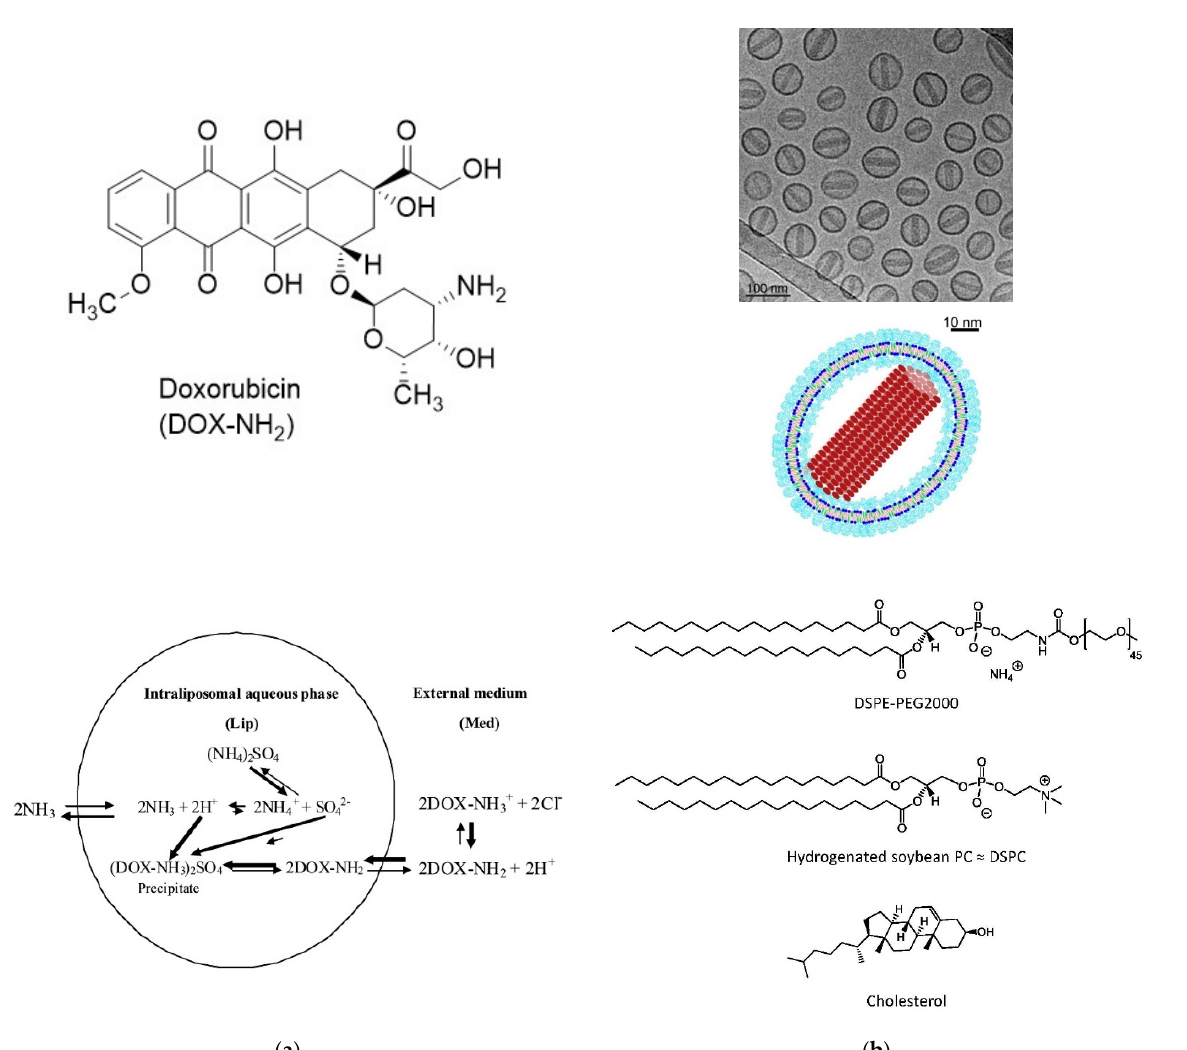
Figure 25. Doxil ® , as prepared by using the “remote loading method”. ( a ) Top : Chemical structure of doxorubicin (DOX-NH 2 ). The reported pK a -value of the protonated form of the amine (-NH 3+ ) of doxorubicin is 8.15 [323]. Bottom : Schematic representation of the remote loading of doxorubicin into pre-formed phospholipid vesicles. The loading is based on trans-membrane ammonium sulfate and pH-gradients, as published by Barenholz (2001) and (2012) [322,324]. The circle represents a phospholipid bilayer of a LUV, for example prepared by polycarbonate membrane extrusion; see Section 4.1. [323]. The arrows in bold indicate the situation during the loading process; see [324] and text for details. ( b ) Top : Cryo-TEM image of commercial Doxil ® , consisting of PEGylated phospholipid vesicles and internal doxorubicin precipitates, obtained via the remote loading mechanism shown in ( a ); see [324]. Middle : Illustration of the structure of a Doxil ® product vesicle (not drawn to scale), consisting of internal doxorubicin precipitates and a single bilayer composed of HSPC (hydrogenated soybean phosphatidylcholine), DSPE-PEG2000, and cholesterol [329] ( bottom ); see Section 6.2.1. Reproduced with permission from [324], Elsevier, 2012; and from [329], Elsevier, 2016.